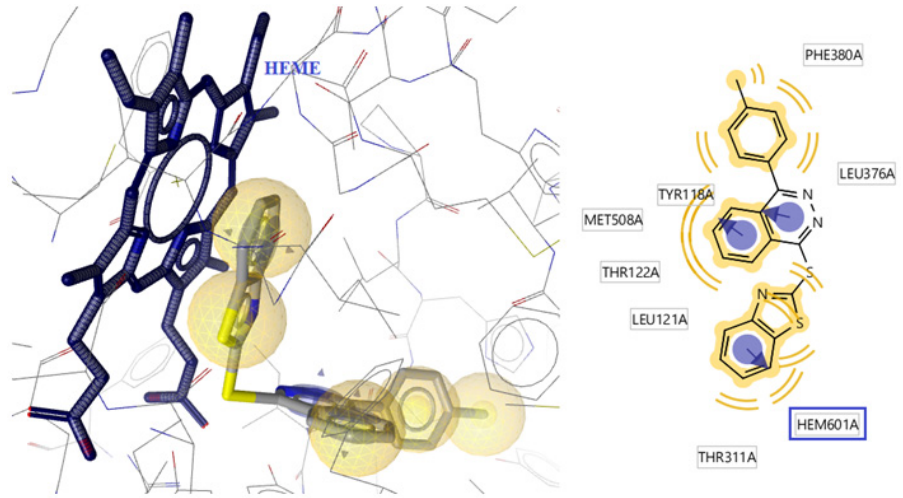
Figure 5. Docked conformation of the most active compound 2d in lanosterol 14 α -demethylase of C . albicans (CYP51 ca ). Blue arrows aromatic interactions and yellow spheres hydrophobic interactions.